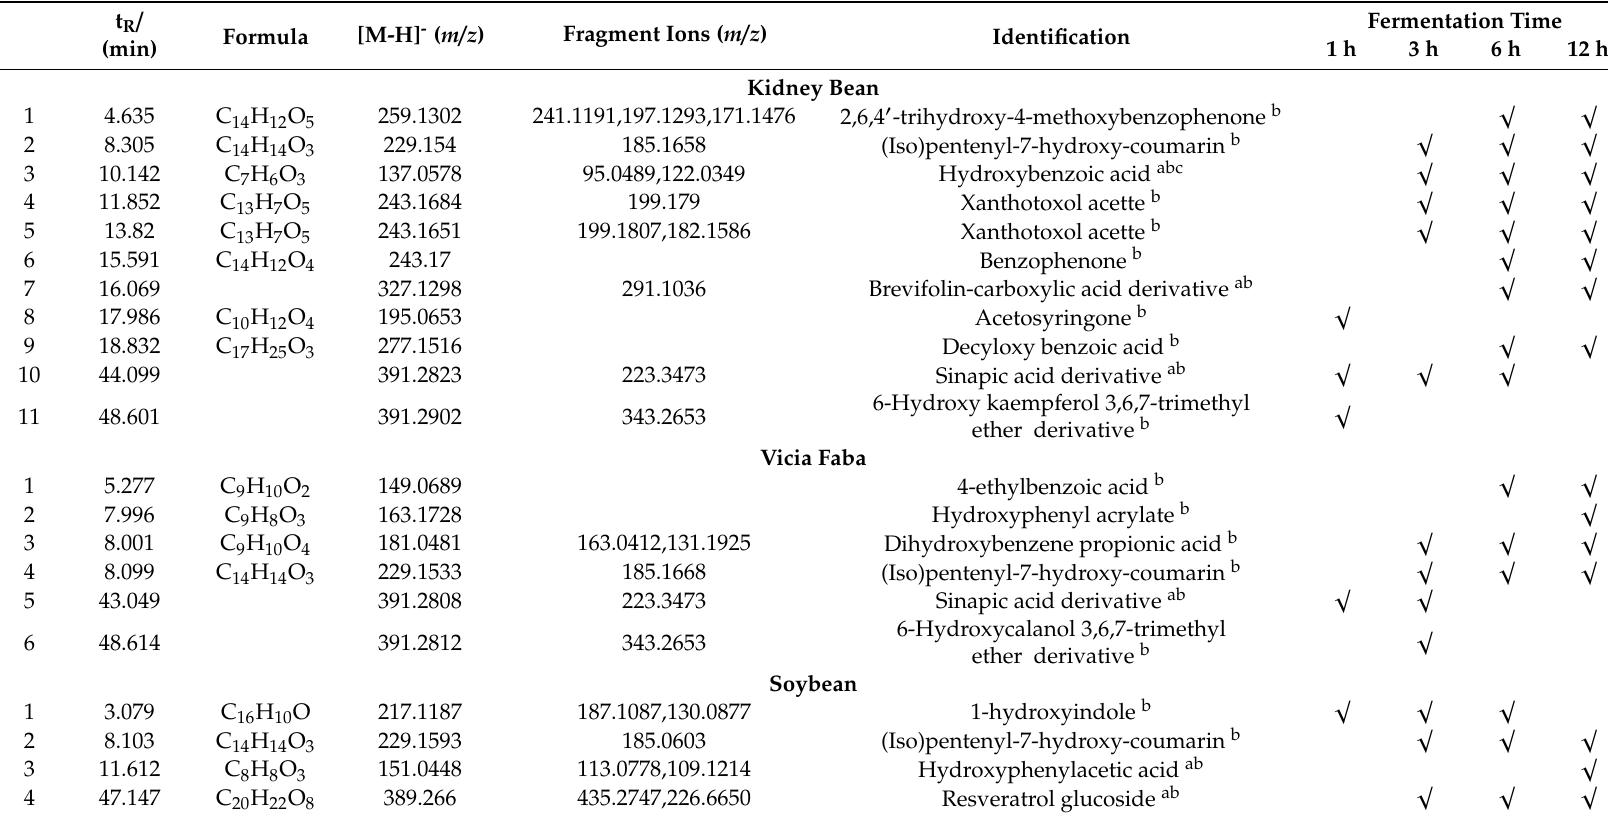
Table 6. Characterization of compounds during colonic fermentation by